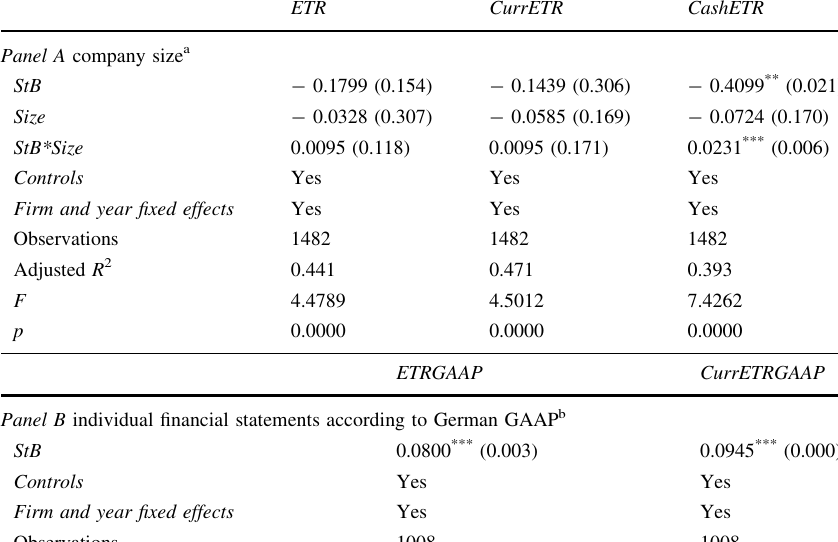
Table 8 Robustness checks—individual auditor